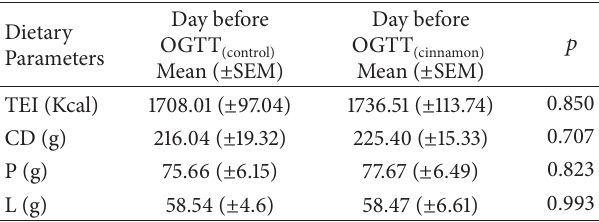
Table 2: Dietary analysis of total energy intake (TEI), carbohydrates (CD), protein (P), and lipid (L) intake at the day before OGTT (control) and at the day before OGTT by participants. Data are mean (cinnamon) ± SEM; 𝑛 = 15 , each group.